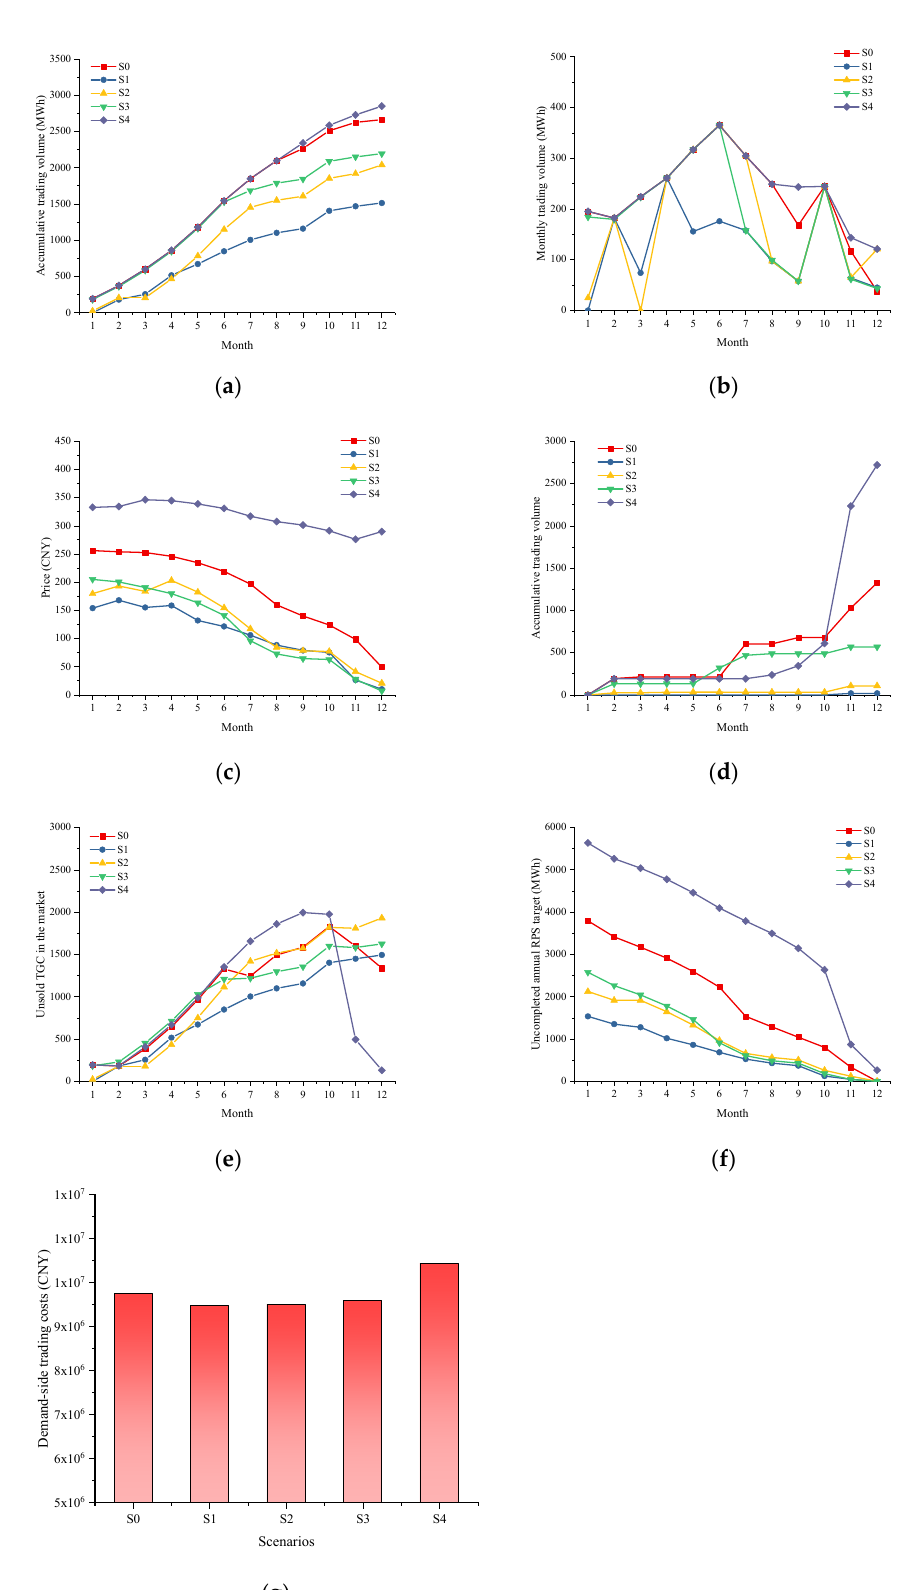
Figure 8. Trends of decision-making and market performance under different RPS weights. ( a ) Accumulative renewable-power trading volume. ( b ) Monthly renewable-power trading volume. ( c ) TGC price. ( d ) Accumulative TGC trading volume. ( e ) Accumulative unsold TGCs. ( f ) RPS target completion. ( g ) Responsible subjects’ cost.